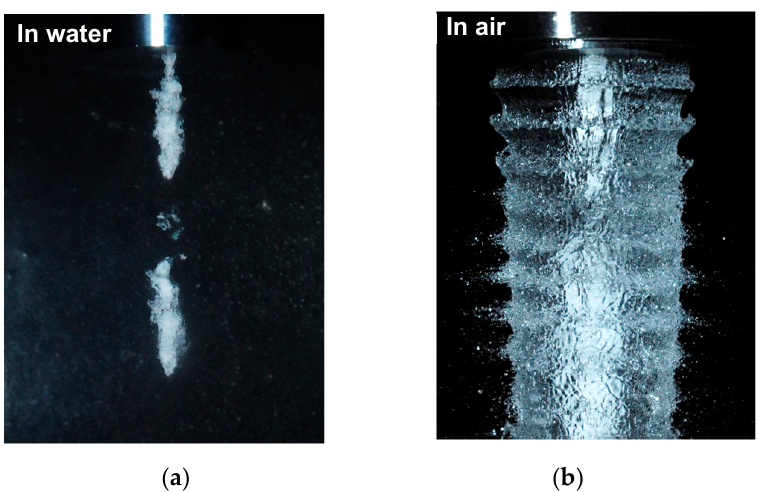
Figure 1. Typical aspects of cavitating jet: ( a ) cavitating jet in water; ( b ) cavitating jet in air.